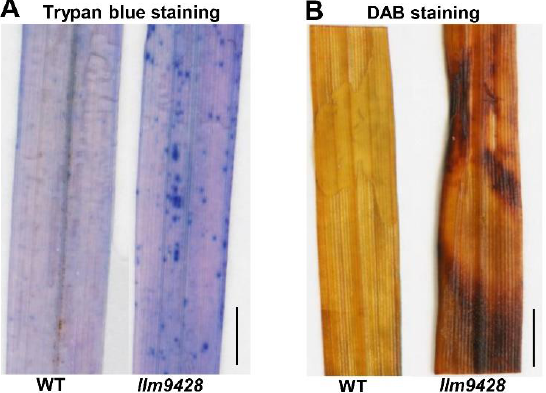
Figure 2. Histochemical staining of WT and llm9428 . ( A ) Trypan blue staining of leaf section of WT and llm9428 . ( B ) DAB staining of leaf section of WT and llm9428 . Scale bar: 1 cm.